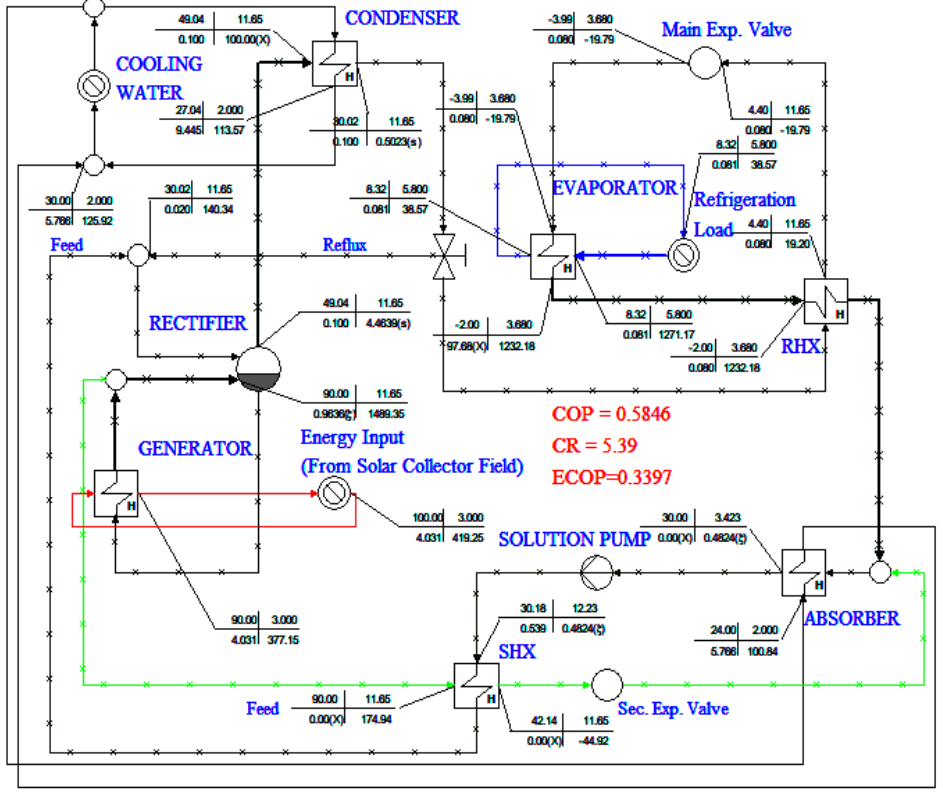
Figure 2. Single stage NH 3 /H 2 O absorption system in Cycle-Tempo scheme window.